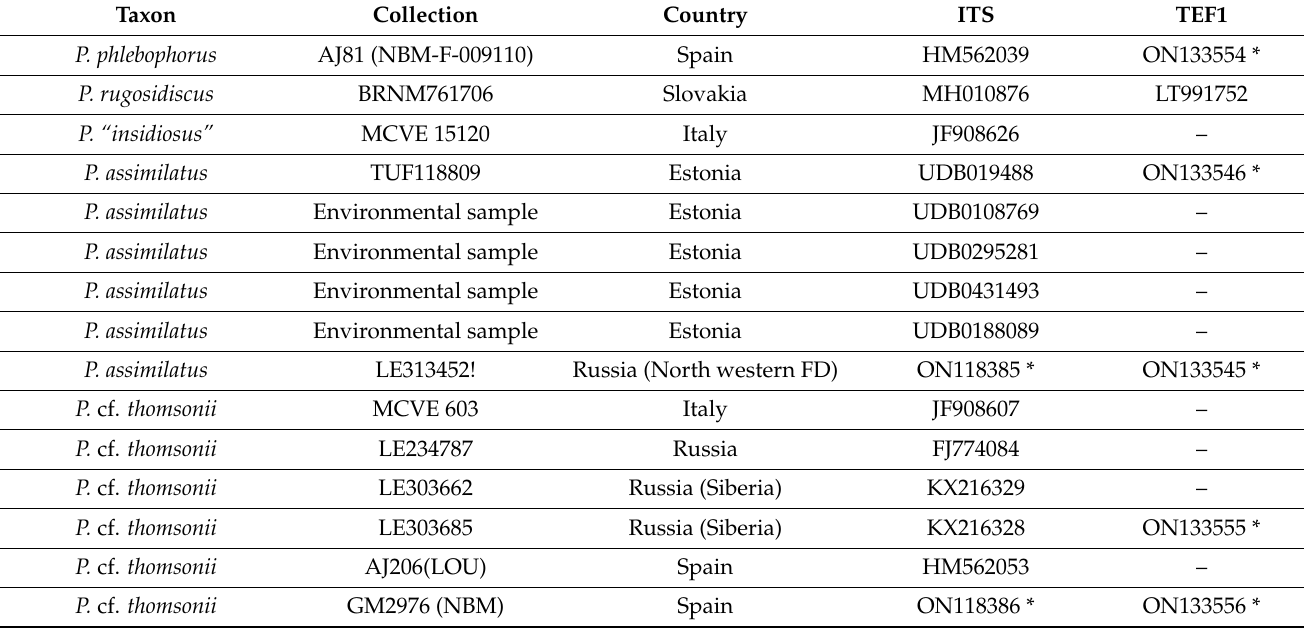
Table 1. Pluteus collections used in phylogenetic analyses. Sequences with an * were newly generated for this